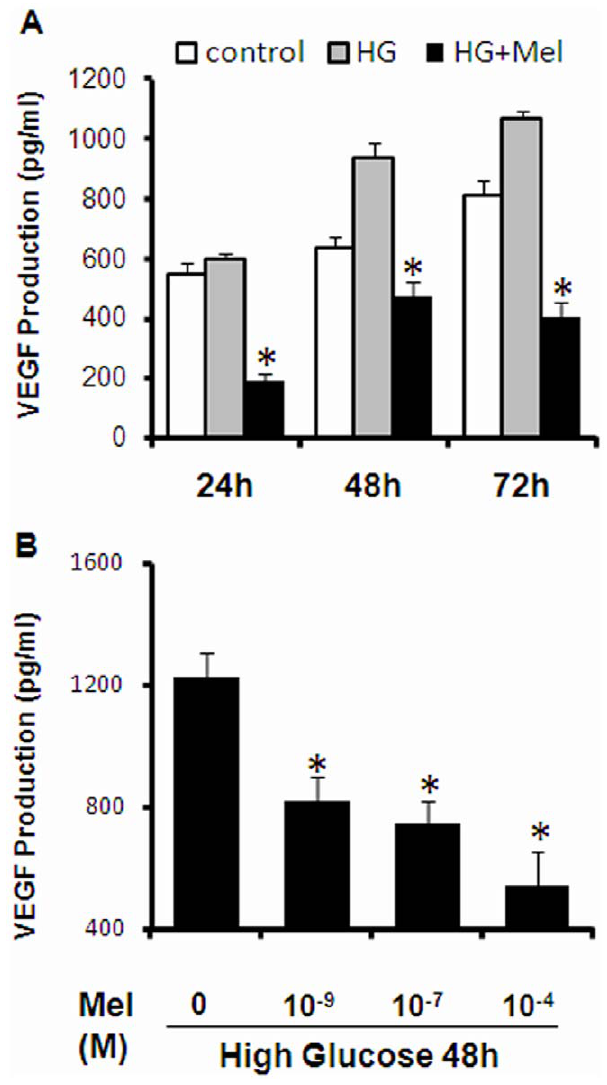
Figure 2. Melatonin-mediated inhibition of VEGF production from Mu¨ller cells. (A) Cells were treated with either 30 mM glucose (HG) or glucose and 100 m M melatonin (HG + Mel) for indicated time. The amount of VEGF secreted in the conditioned media was measured by ELISA. (B) Dose-dependent inhibition of VEGF production by melatonin. VEGF production was measured at 48 hr after high glucose stimulation in the presence of different concentrations of melatonin. Data presented are the average of 2 separate experiments. *P , 0.05 one- way ANOVA and Tukey’s post-hoc test.